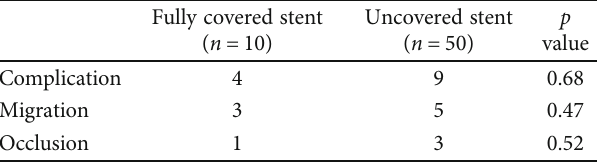
Figure 2: Covered stent migration. Table 2: Compare of stent